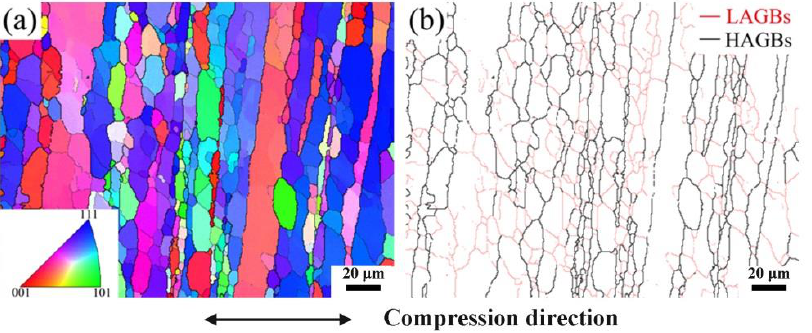
Figure 1. Microstructure morphology of Al-Zn-Mg-Cu alloy: ( a ) inverse pole figure (IPF); ( b ) high- and low-angle grain boundaries.